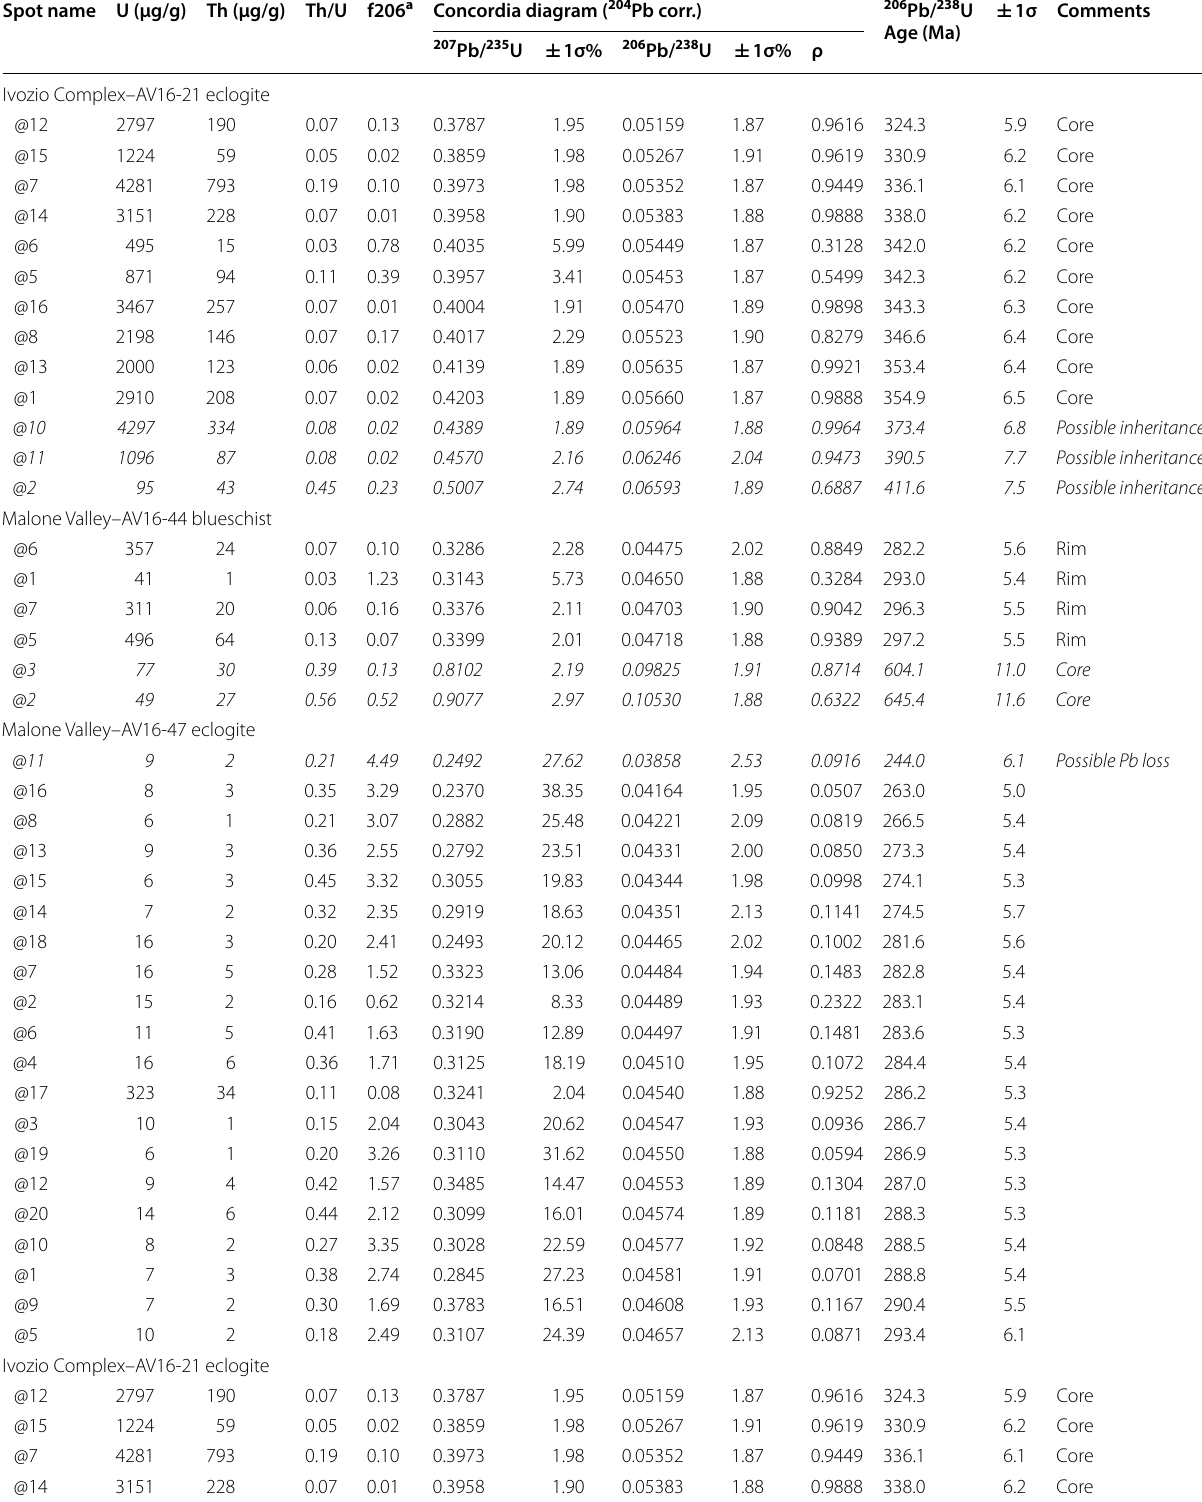
Table 2 U, Th and Pb SIMS zircon data of the eclogite AV16-21 from Ivozio Complex, the eclogite AV16-47 and the blueschist AV16-44 from Malone